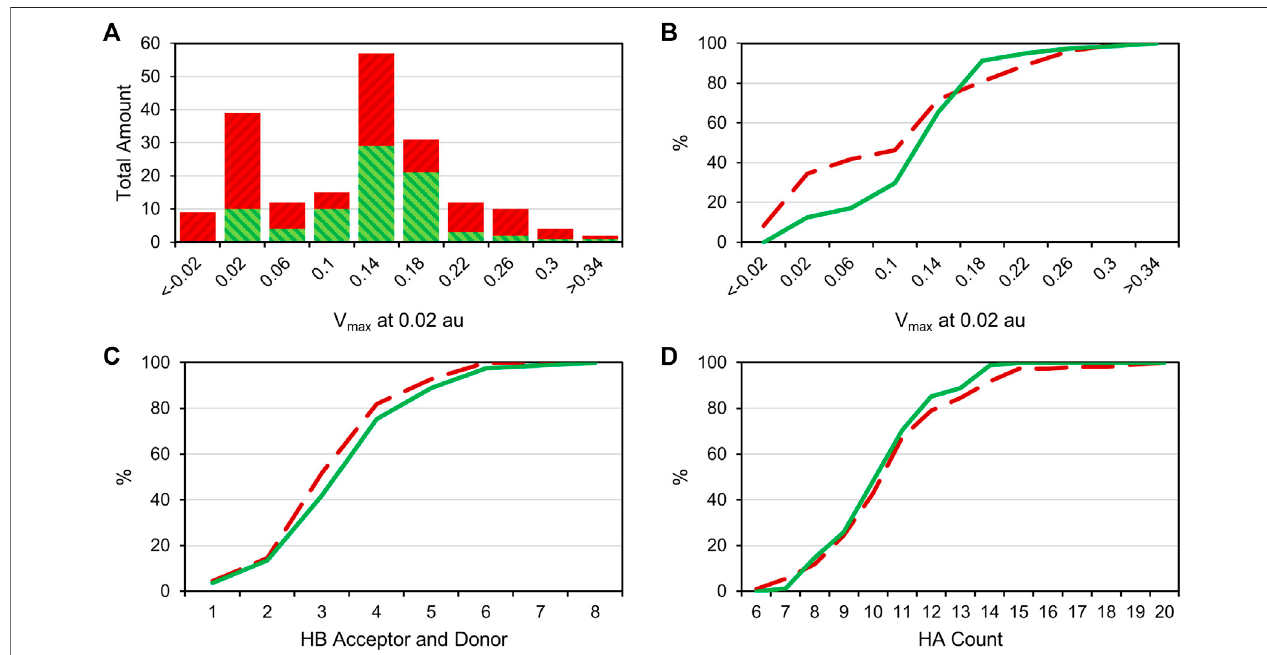
FIGURE 3 | (A) : Bar plot comparing the V max -value at 0.02 au of all hit compounds (green) with the uneventful compounds (red). (B) : Cumulative distribution of the V max data;greenisthedistributionofhitcompounds,andred(dashed)isthedistribution ofuneventfulcompounds. ArightshiftofhitstowardshigherV max valuescanbe observed. (C) : Cumulative distribution of HB acceptors and donors. (D) : Cumulative distribution of (non-hydrogen) heavy atom (HA) number. No particular shift in the distribution is observable in panels C and